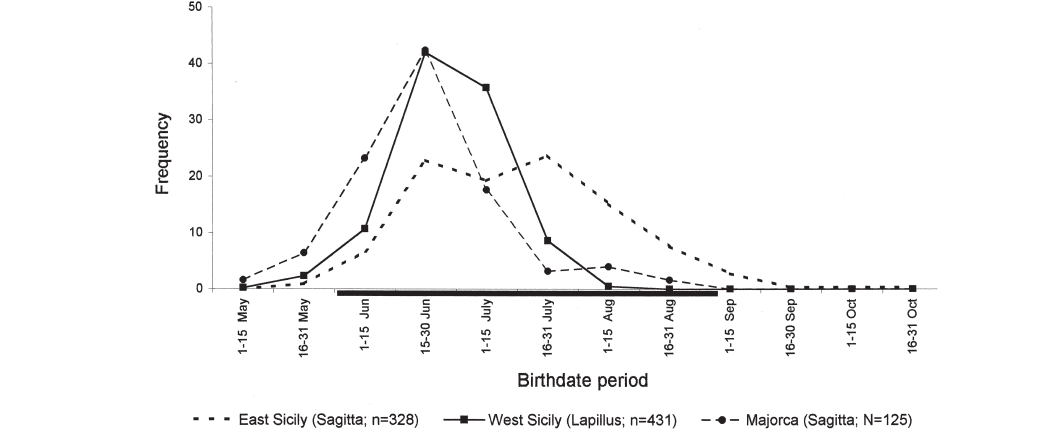
F IG . 7. – Hatchdate distribution back-calculated from the date of capture and the age determined from sagittae for two areas and methods, and lapilli interpretation. In the x-axis the peak spawning period is indicated (Massutí and Morales-Nin,